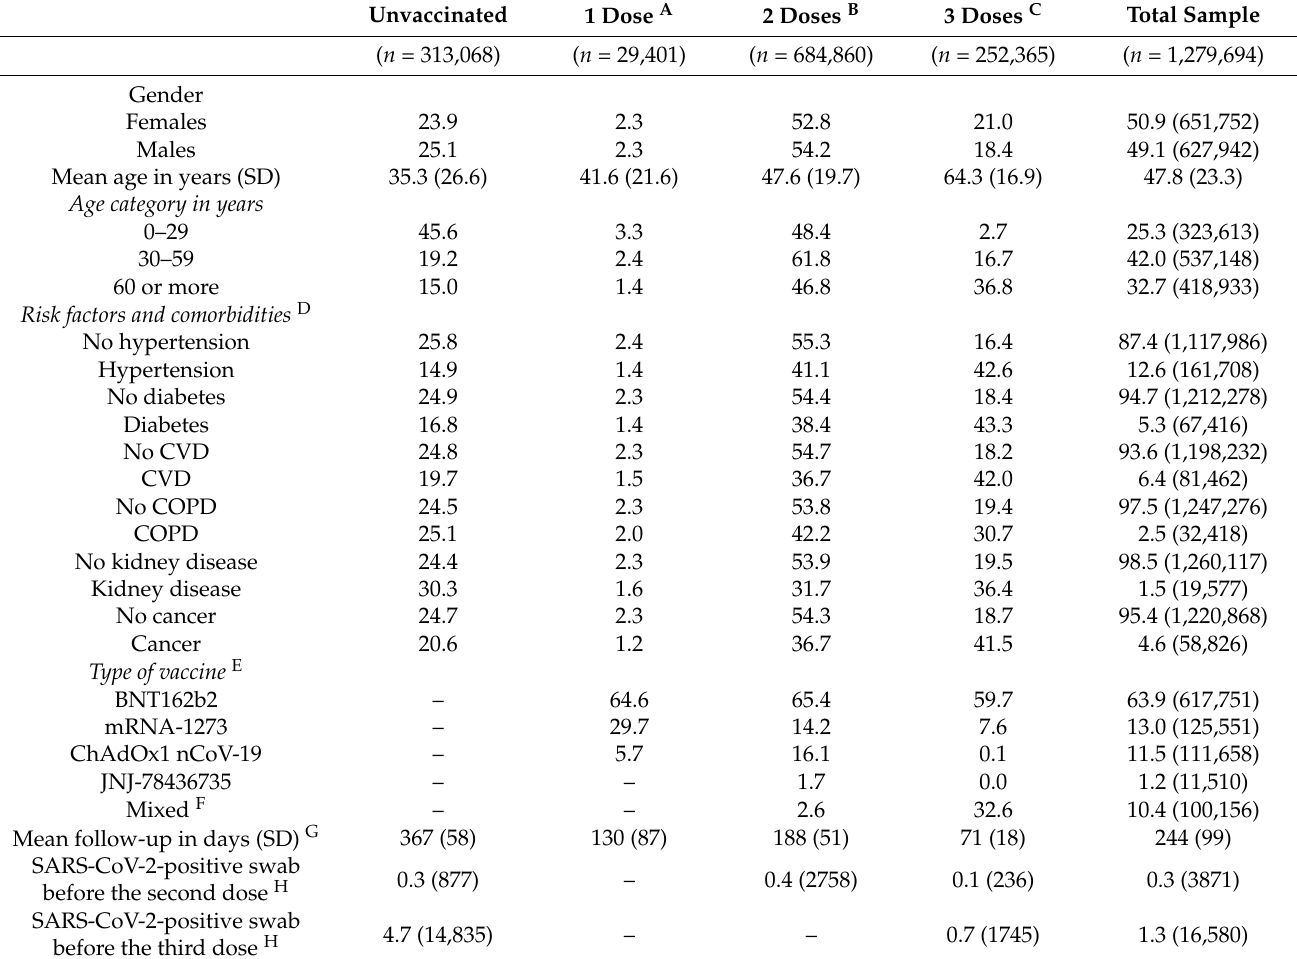
Table 1. Main characteristics of the sample, overall and by vaccine